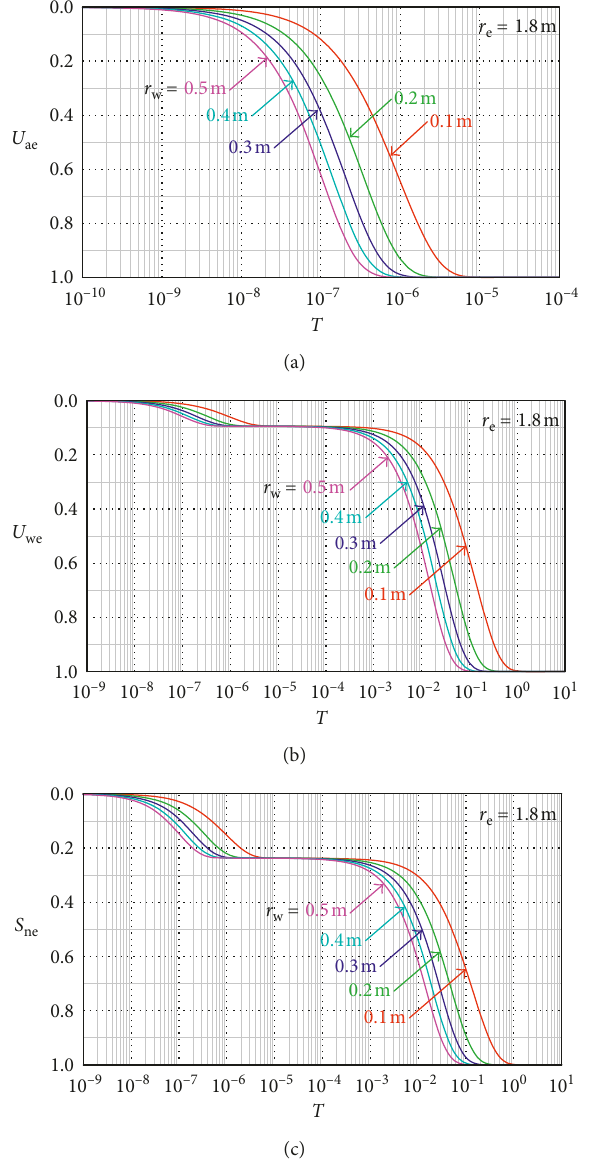
Figure 4: Degrees of consolidation of (a) air phase, (b) water phase, and (c) normalized settlement varying with different values of r